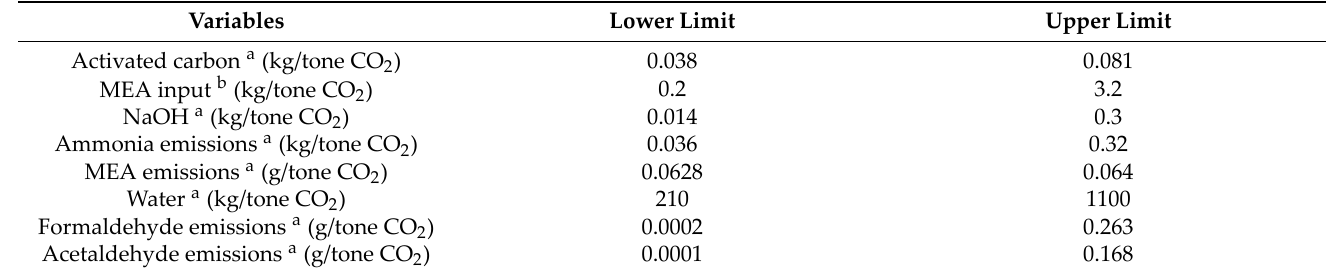
Table 7. Values for the parameters in the sensitivity analysis.